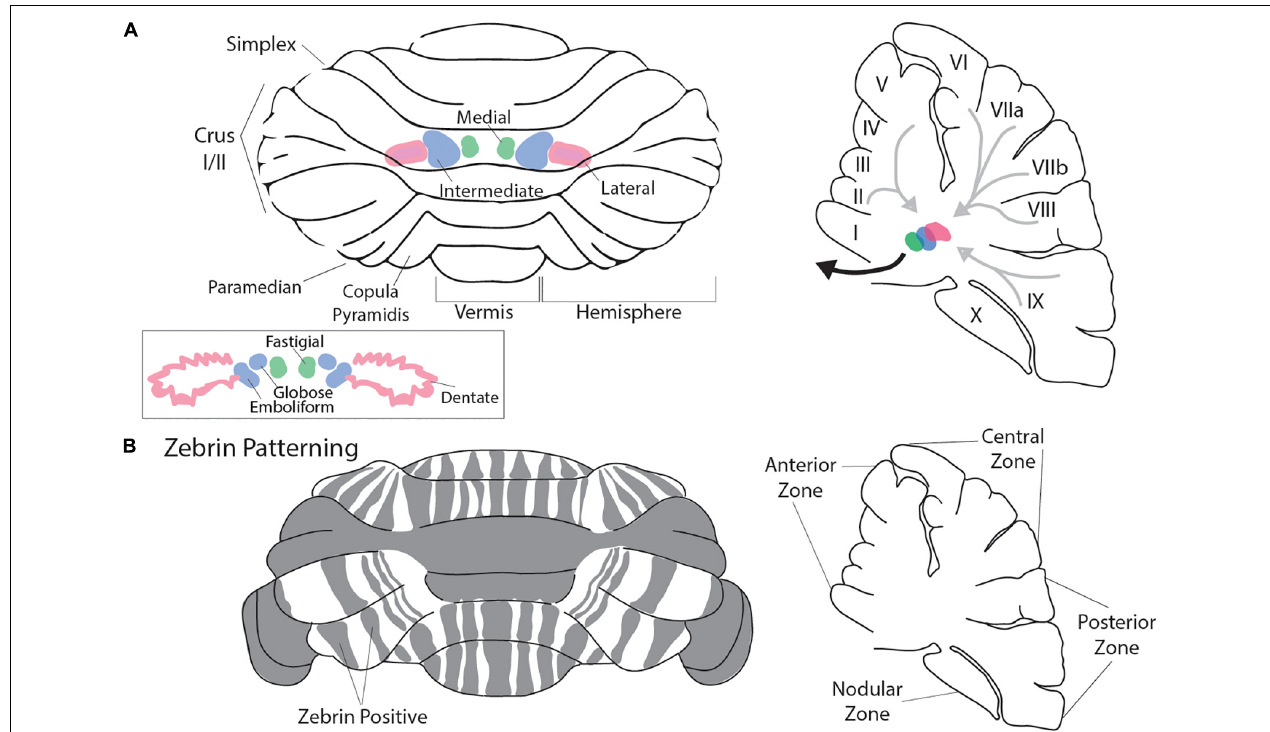
FIGURE 2 | Macroarchitecture of the cerebellum. Rodent cerebellum (A) depicted from the dorsal view (left panel). Rostral is superior and caudal is inferior. Vermis is midline. The cerebellar nuclei (CN) are represented in color. In pink is the lateral nucleus, in green is the medial nucleus, and in blue is the intermediate nucleus ( A ; inset). Pictured are the primate cerebellar nuclei: lateral is the dentate (Pink) where the convoluted shape in comparison to the rodent lateral nucleus can be appreciated, medial is the fastigial (green), and the globose and emboliform nuclei (blue; together forming the interposed nuclei) are pictured and are analogous to the murine intermediate nucleus. The right panel presents a parasagittal view of the cerebellum at midline. The cerebellar nuclei are indicated as in the left panel (adapted in part from Sugihara et al., 1999 permission was obtained from Wiley Online Library). Light gray arrows represent schematized Purkinje cell output to the CN, while the heavy black arrow represents CN efferent projections to the cerebral cortex and brainstem. Mouse cerebellum (B) depicted from the dorsal view (left panel). Gray indicates representative Zebrin banding pattern. Orientation is as described in (A) . The Right panel indicates the mouse cerebellum at midline in the parasagittal plane with zonal nomenclature. Mouse cerebellum adapted from Cerminara et al. (2015). Permission was obtained from Nature research